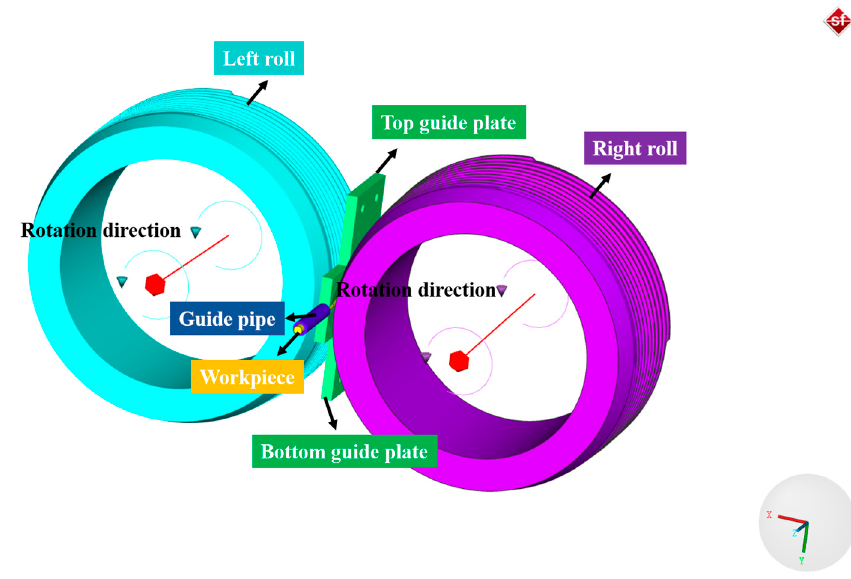
Figure 1. FE model of the cold skew rolling process of steel balls. Table 2. Chemical composition of 316L SS.